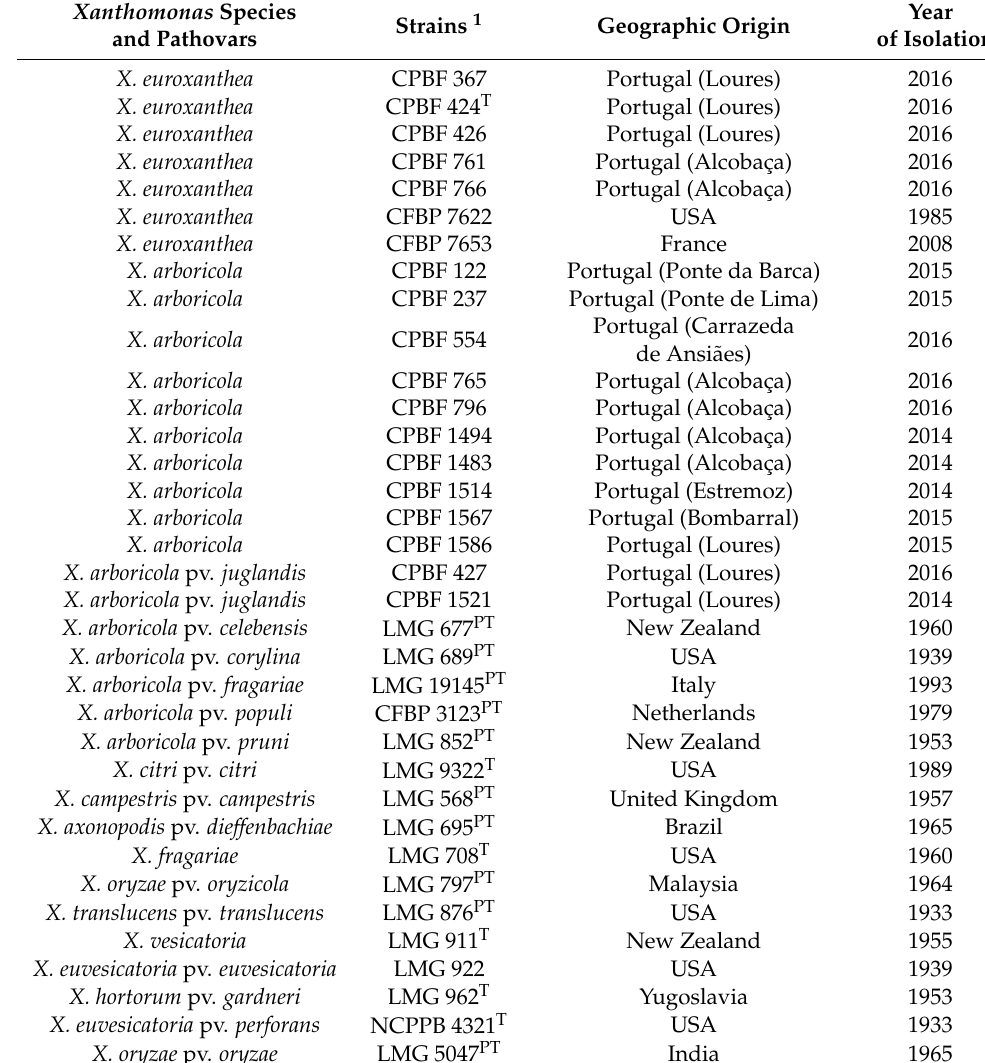
Table 2. List of bacterial strains used for validation of the Xanthomonas euroxanthea -specific DNA